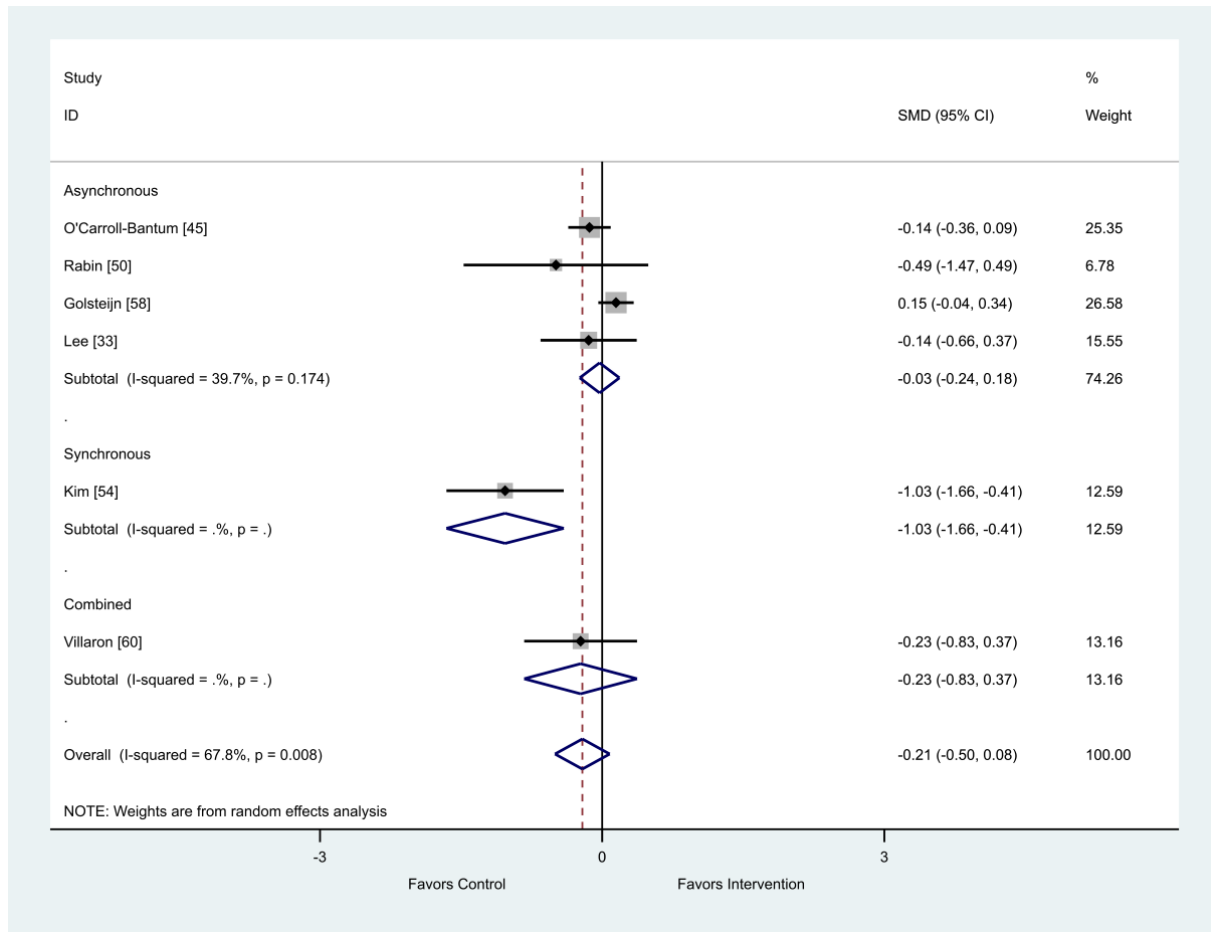
Figure 8. Effect of electronic health interventions with a control on fatigue interventions, analyzed using standardized mean difference (postintervention mean and SD). Lower scores indicate improved fatigue. SMD: standardized mean